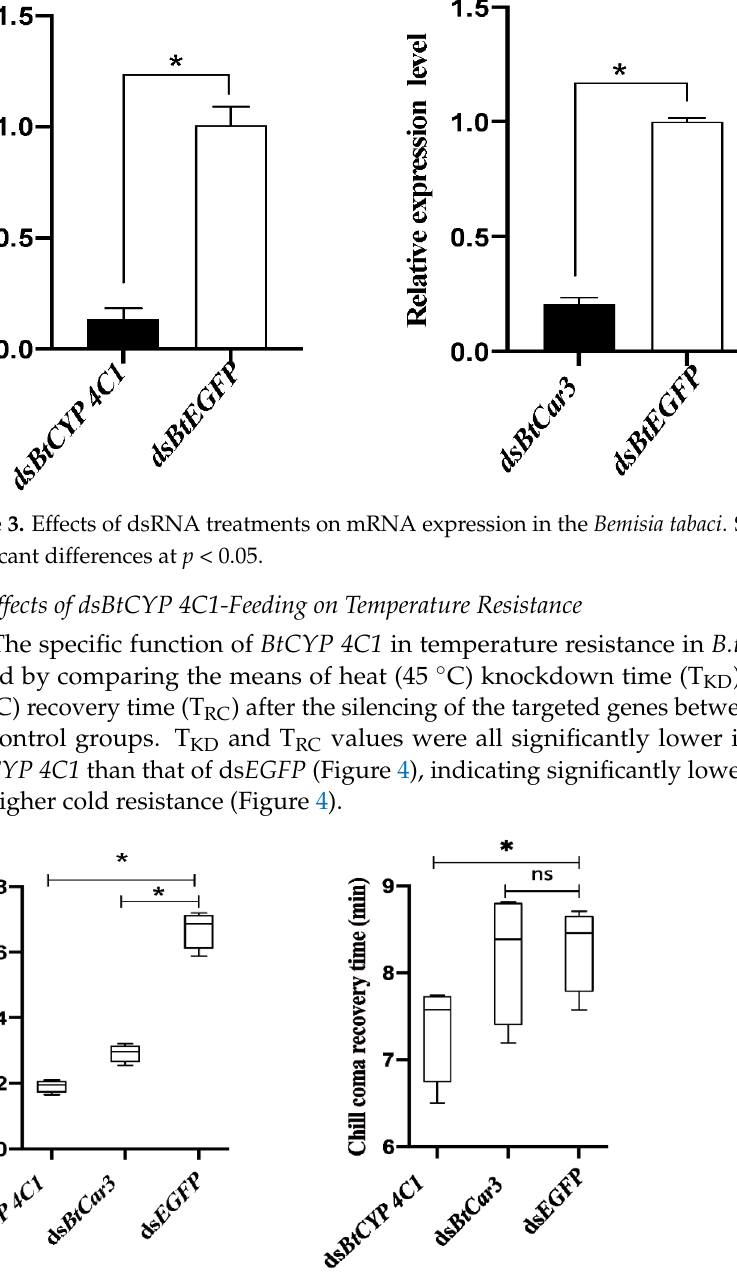
Figure 4. Trait means of heat and cold tolerances after feeding Bemisia tabaci with dsRNA of the BtCYP 4C1 and BtCar3 genes. Numbers are means ±1S.E. N = 200 in all cases. Symbol * indicates significant differences at p < 0.05.